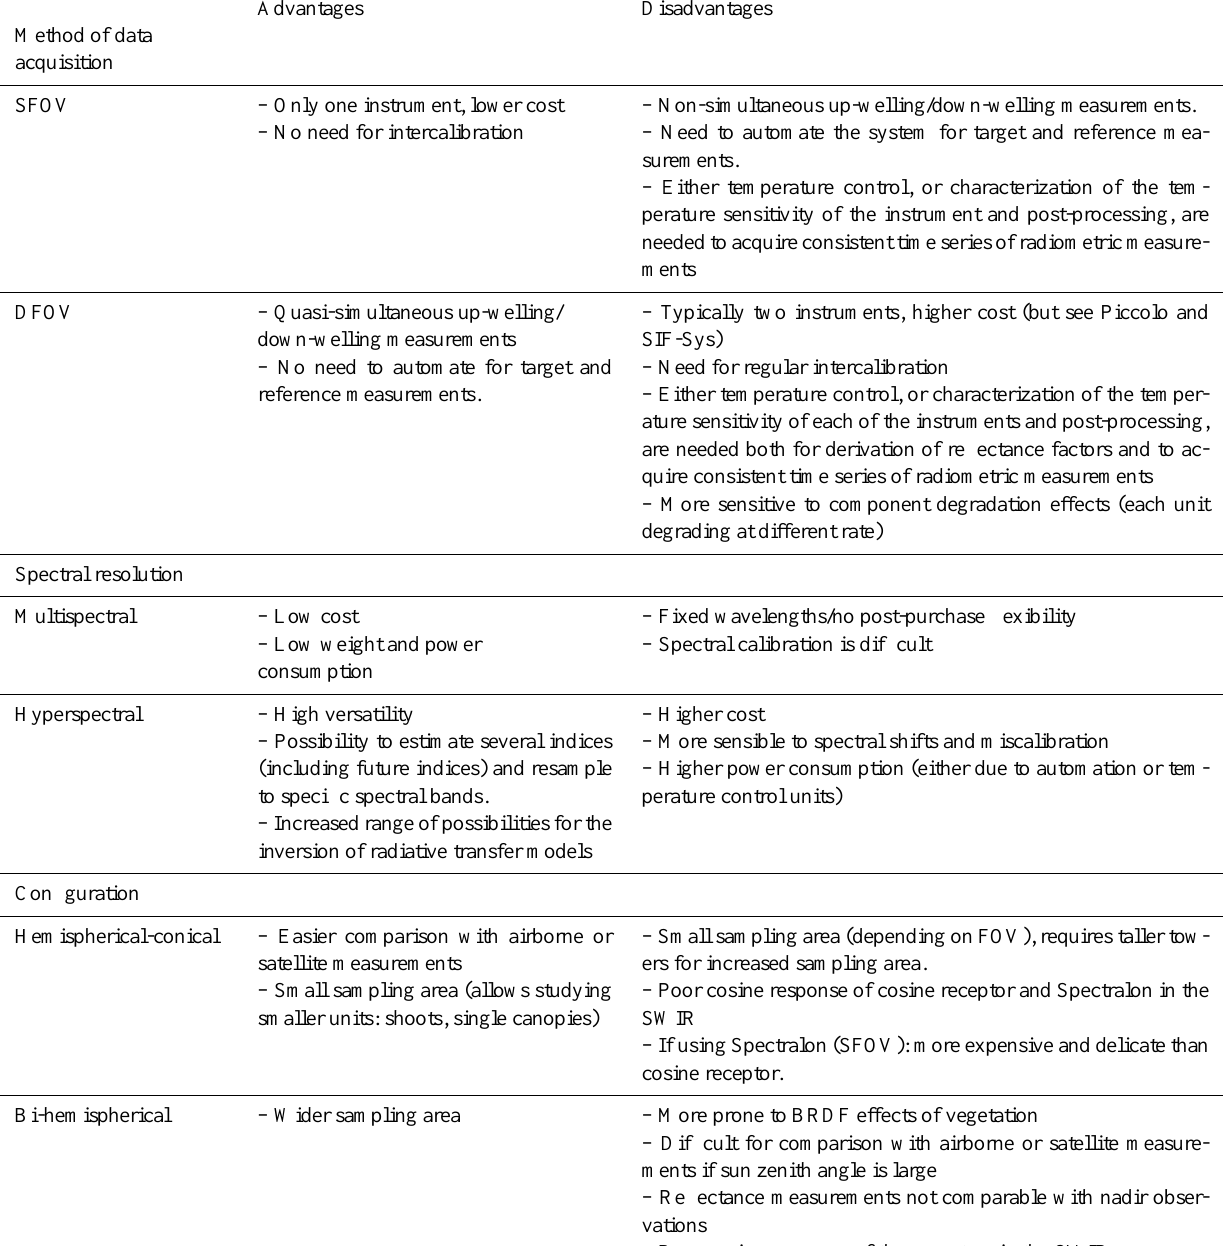
Table 1. Advantages and disadvantages of different approaches and configurations for in situ spectral